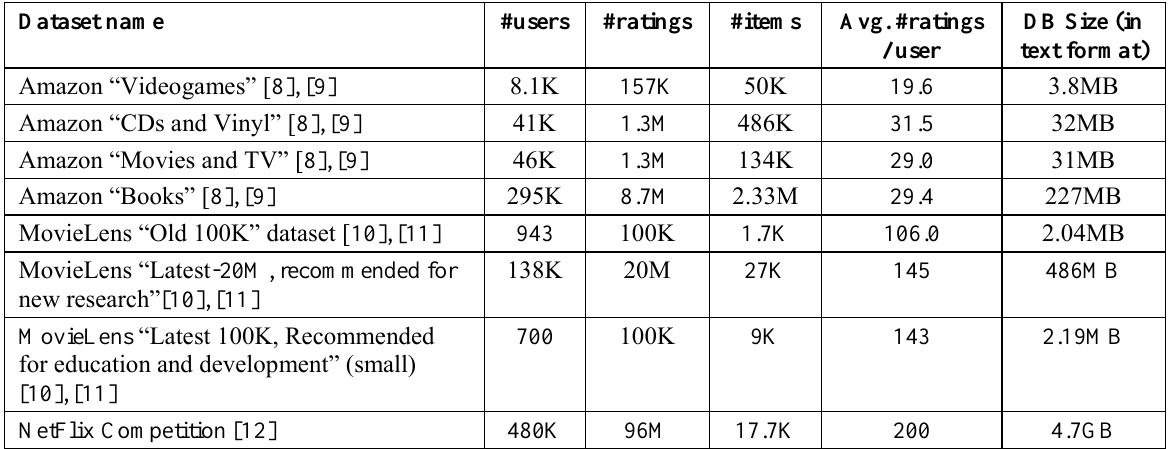
Table 1. Datasets